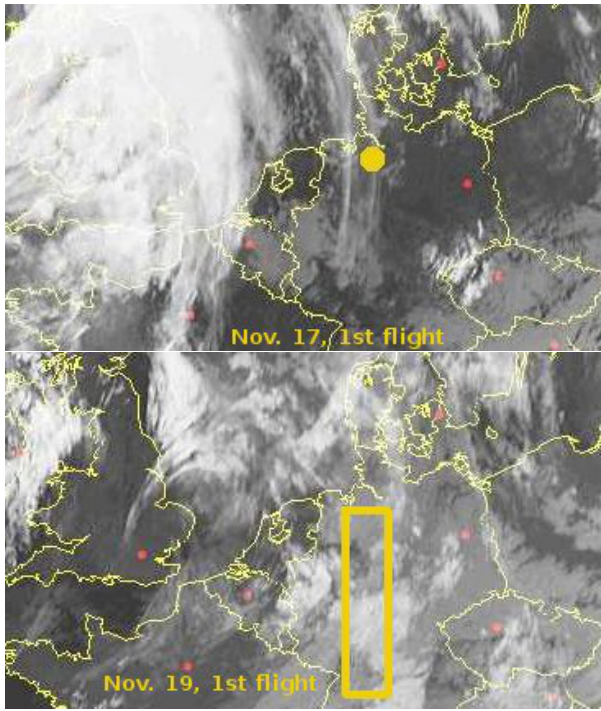
Fig. 2. Left panel: Frequency of occurrence of RH ice in contrails, cirrus and clear sky during CONCERT (solid lines) and for a broad range of cirrus conditions (dotted line, from Kr¨amer et al., 2009, 5.6 h observation time, 28 flights). CONCERT sampling times: clear sky 0.9 h, cirrus 2.3 h, contrails 1.7 h, Flight dates: Oct. 29. (1 flight), Nov. 17 (2 flights), Nov. 19 (2 flights), Nov. 20 (1 flight). Right panel: large ice crystals observed inside of the cirrus and con- trails during CONCERT.